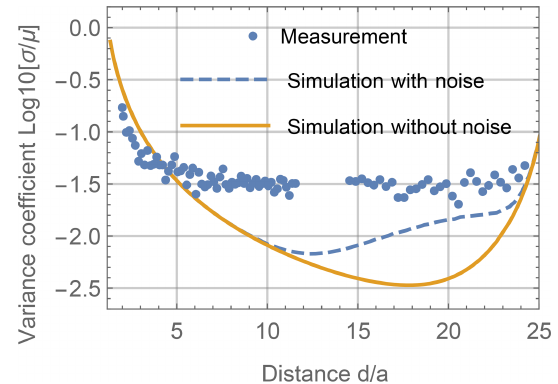
Figure 12. Measured logarithmic variation coefficient c of induced voltage ˆ U z in a pick-up coil for an arbitrarily oriented 3-D coil at different positions d .